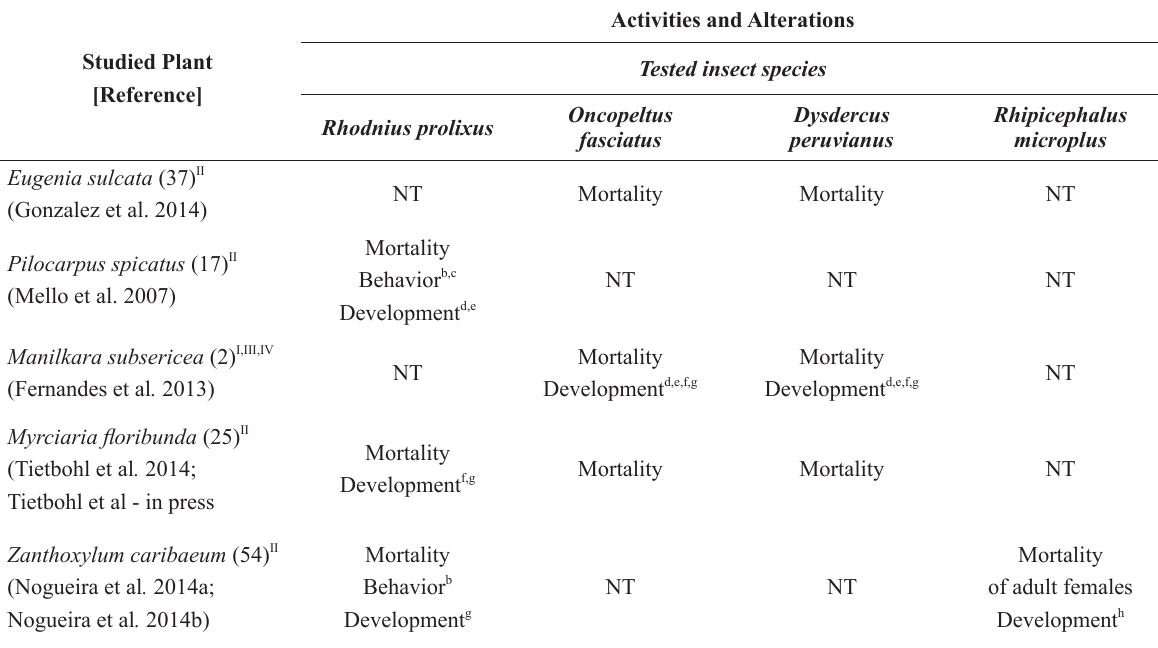
Effects of extracts I , essencial oils II , sample fractions III and purified metabolites IV obtained from plants of Brazilian restinga vegetation on mortality, behavior and development of arthropods of medical or agricultural interest. The number under brackets after the plants species name represents the number of secondary metabolites detected in each